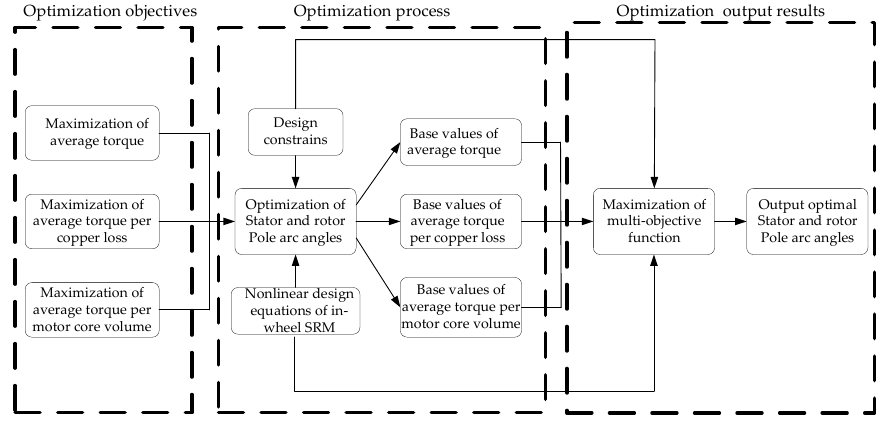
Figure 17. Multi-objective optimization flow chart [68].